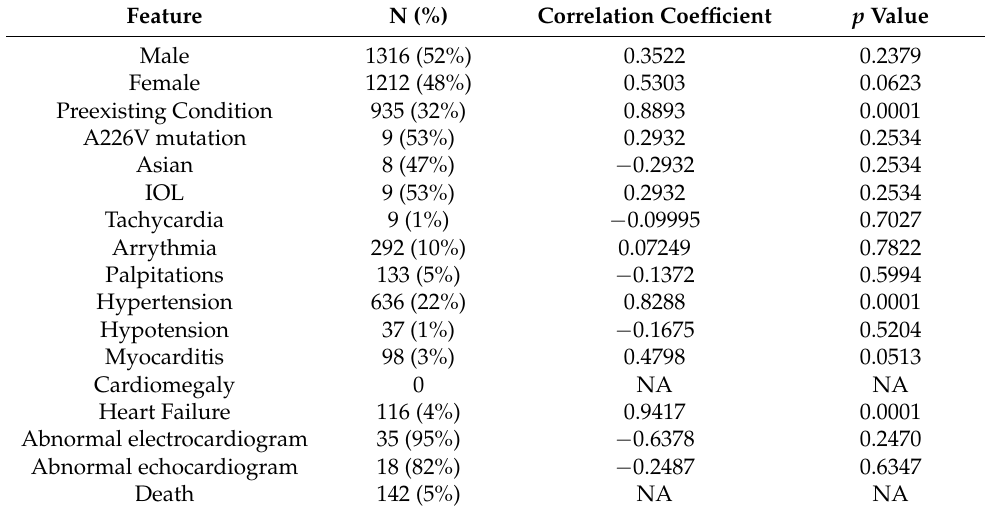
Table 5. Incidence of specific features of CHIKV-infected patients from clinical studies with cardiac symptoms. Pearson’s Correlation Coefficients were obtained to determine if there were any specific features associated with death. Feature N